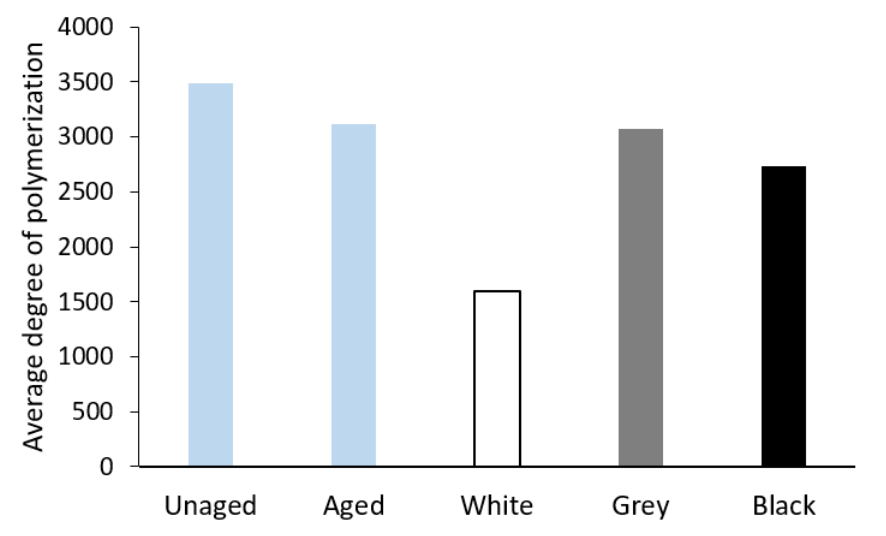
Figure 15. The average degree of polymerization of Whatman Grade 1 paper before aging (Unaged), after artificial aging without contact with PE foam (Aged), and in contact with the tested PE foams.